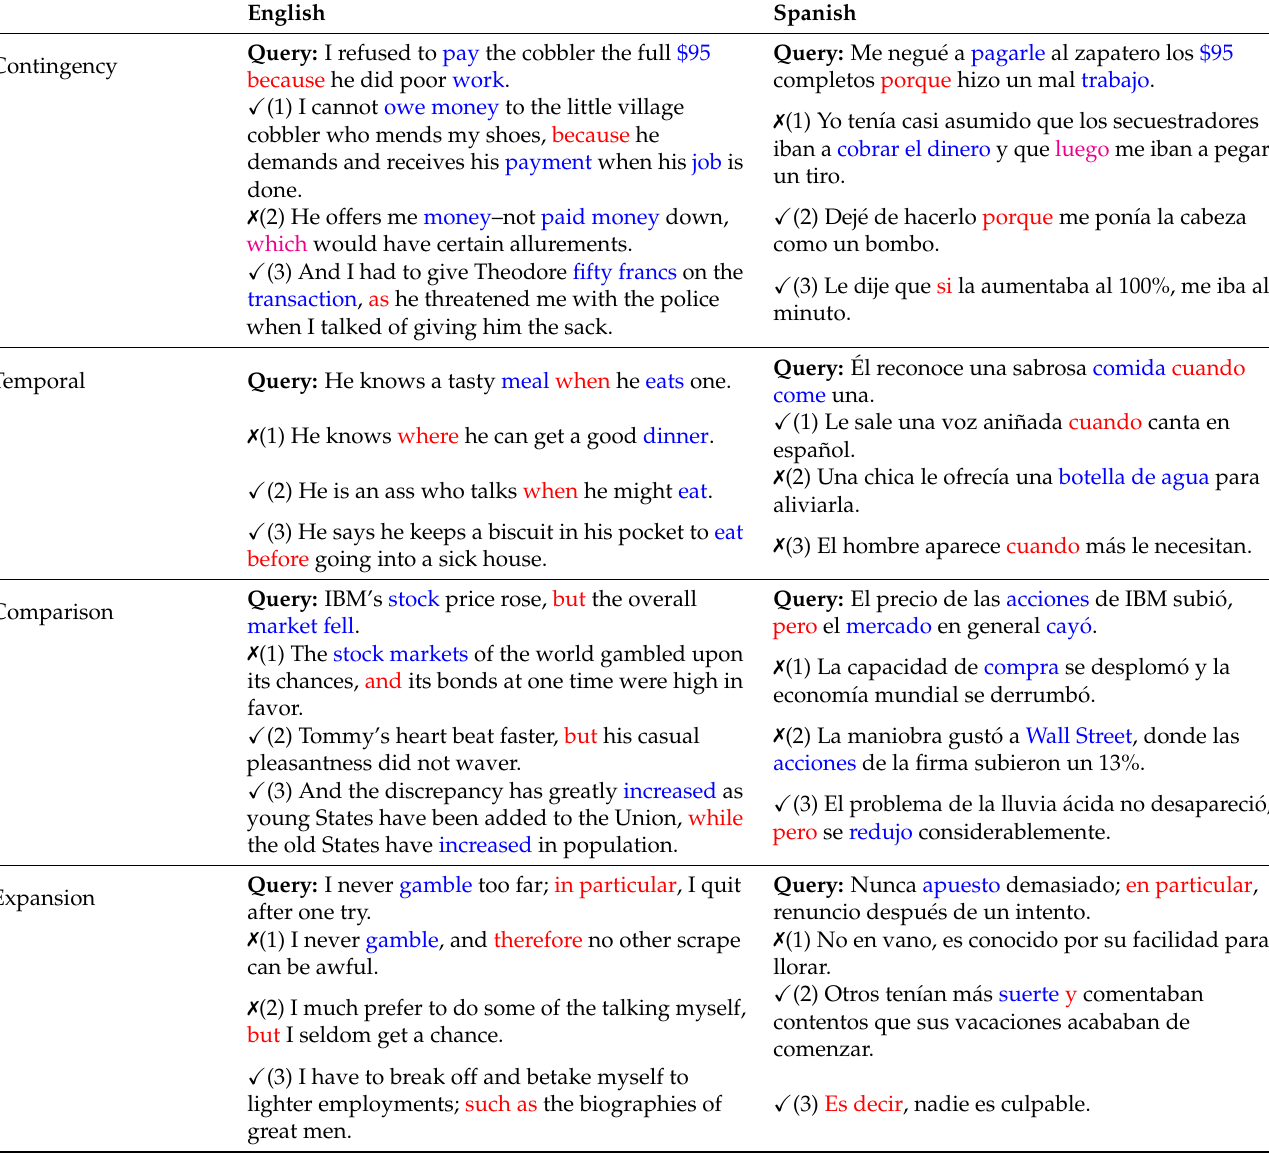
Table 4. Sentences retrieved from an unannotated corpus given an annotated query with discourse relations. Words highlighted in red and blue show discursive connectors and semantic relationships, respectively.